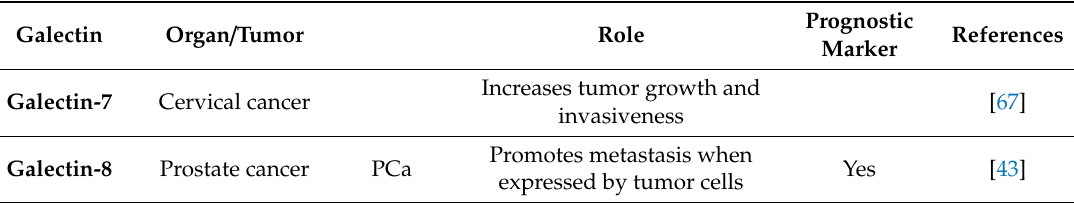
Table 5. Other galectins on immune cells in the tumor